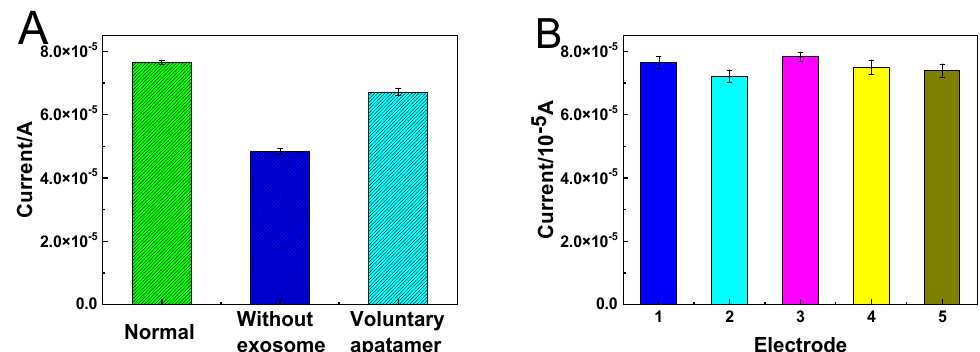
Figure 7. ( A ) Study of the specificity of the electrochemical biosensor toward various interferences. Error bars represent standard deviation, n = 5. The concentration of exosomes was 5.0 × 10 3 exosomes µL − 1 . ( B ) Electrochemical responses of five immunosensor fabricated independently. Table 2. The detection results of exosomes in serum using the